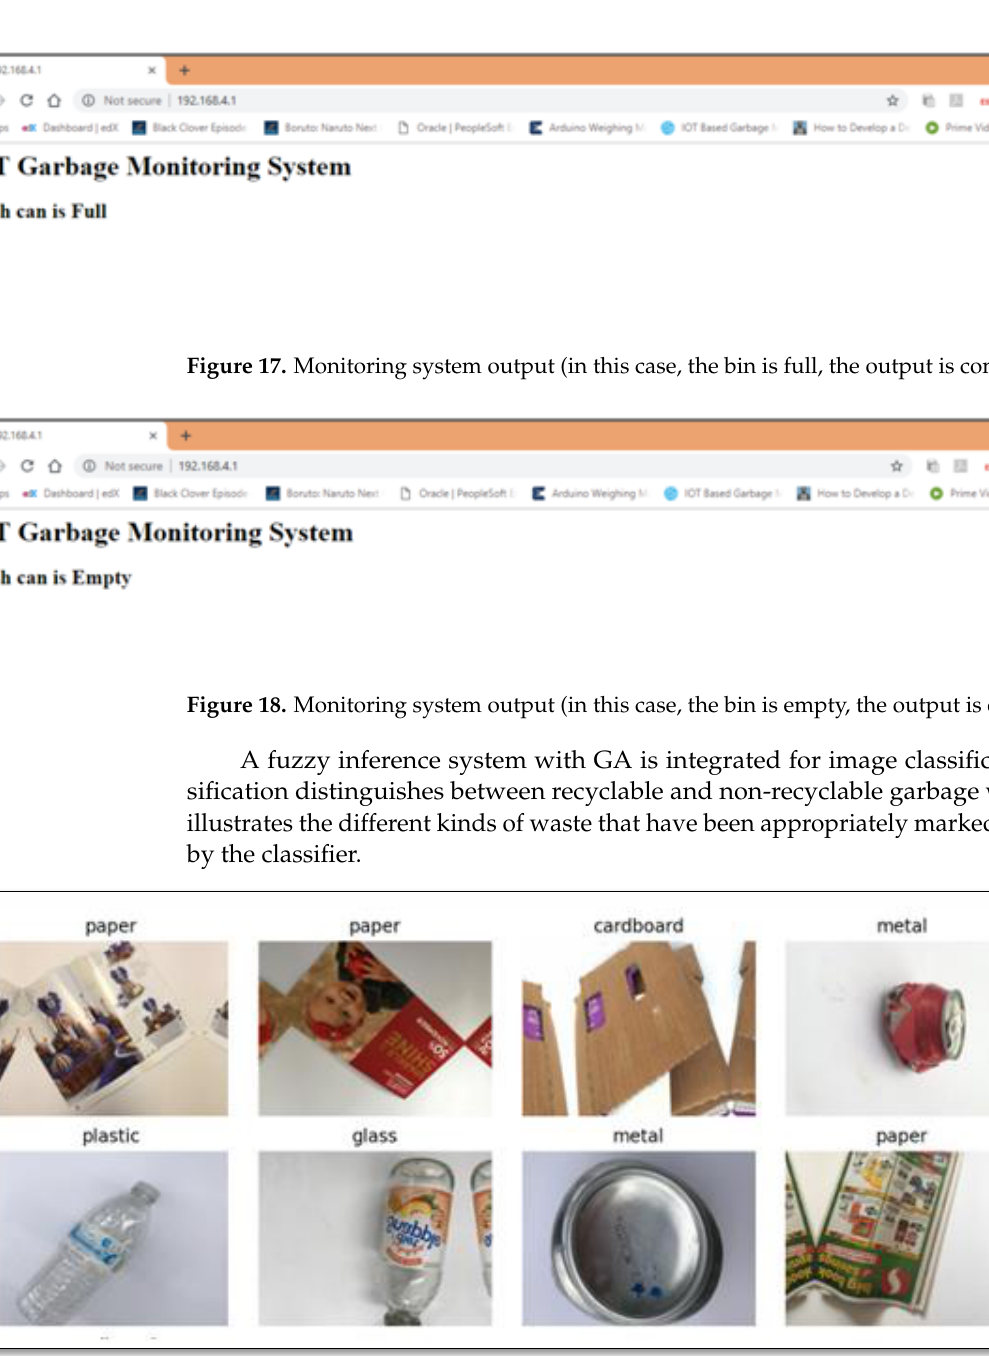
Figure 19. Classification of all the waste particles.